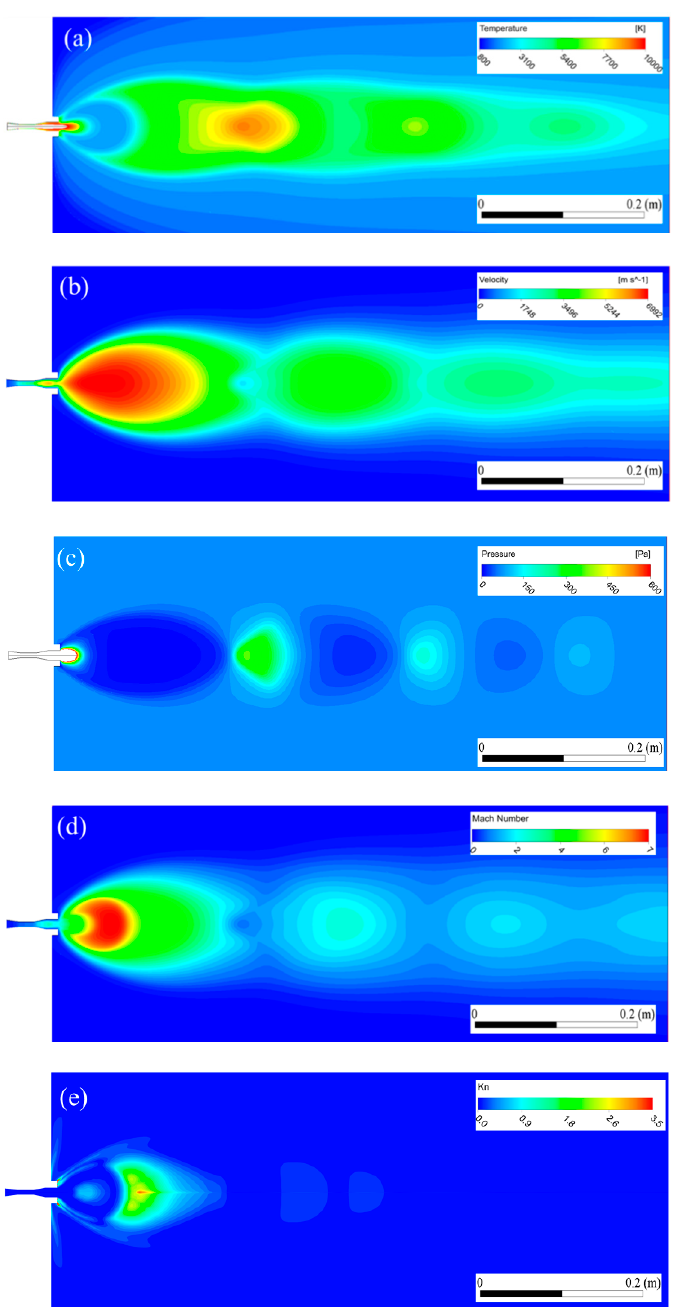
Figure 5. 40Ar–8H2 plasma jet fields at 22.5 kW and 100 Pa: ( a ) temperature, ( b ) velocity, ( c ) pressure, ( d ) Mach number , and ( e ) Knudsen number.